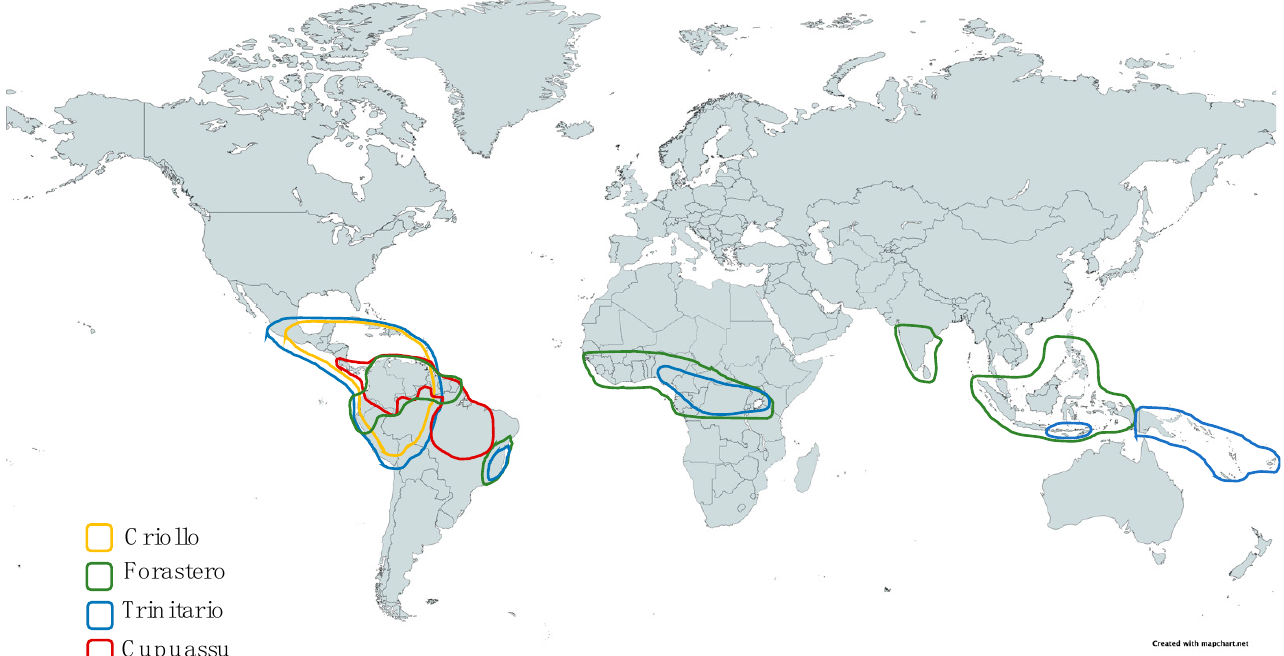
Figure 1. Approximative locations of T. cacao (Criollo, Forastero and Trinitario) and T. grandiflorum (Cupuassu). Data from [1,9,20–24].